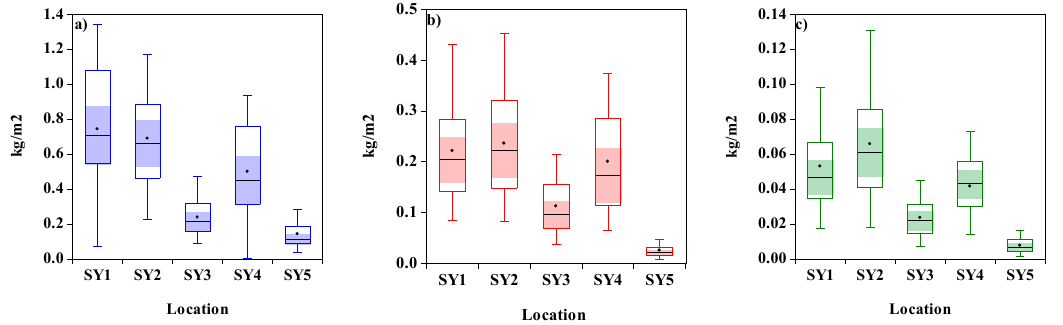
Figure 3. Box plots of soil erosion in each ecosystem (with respect to slope): ( a ) agricultural land; ( b ) burnt forest, and ( c ) forest (median ( _____ ); mean (•); median 95% confidence (shaded).